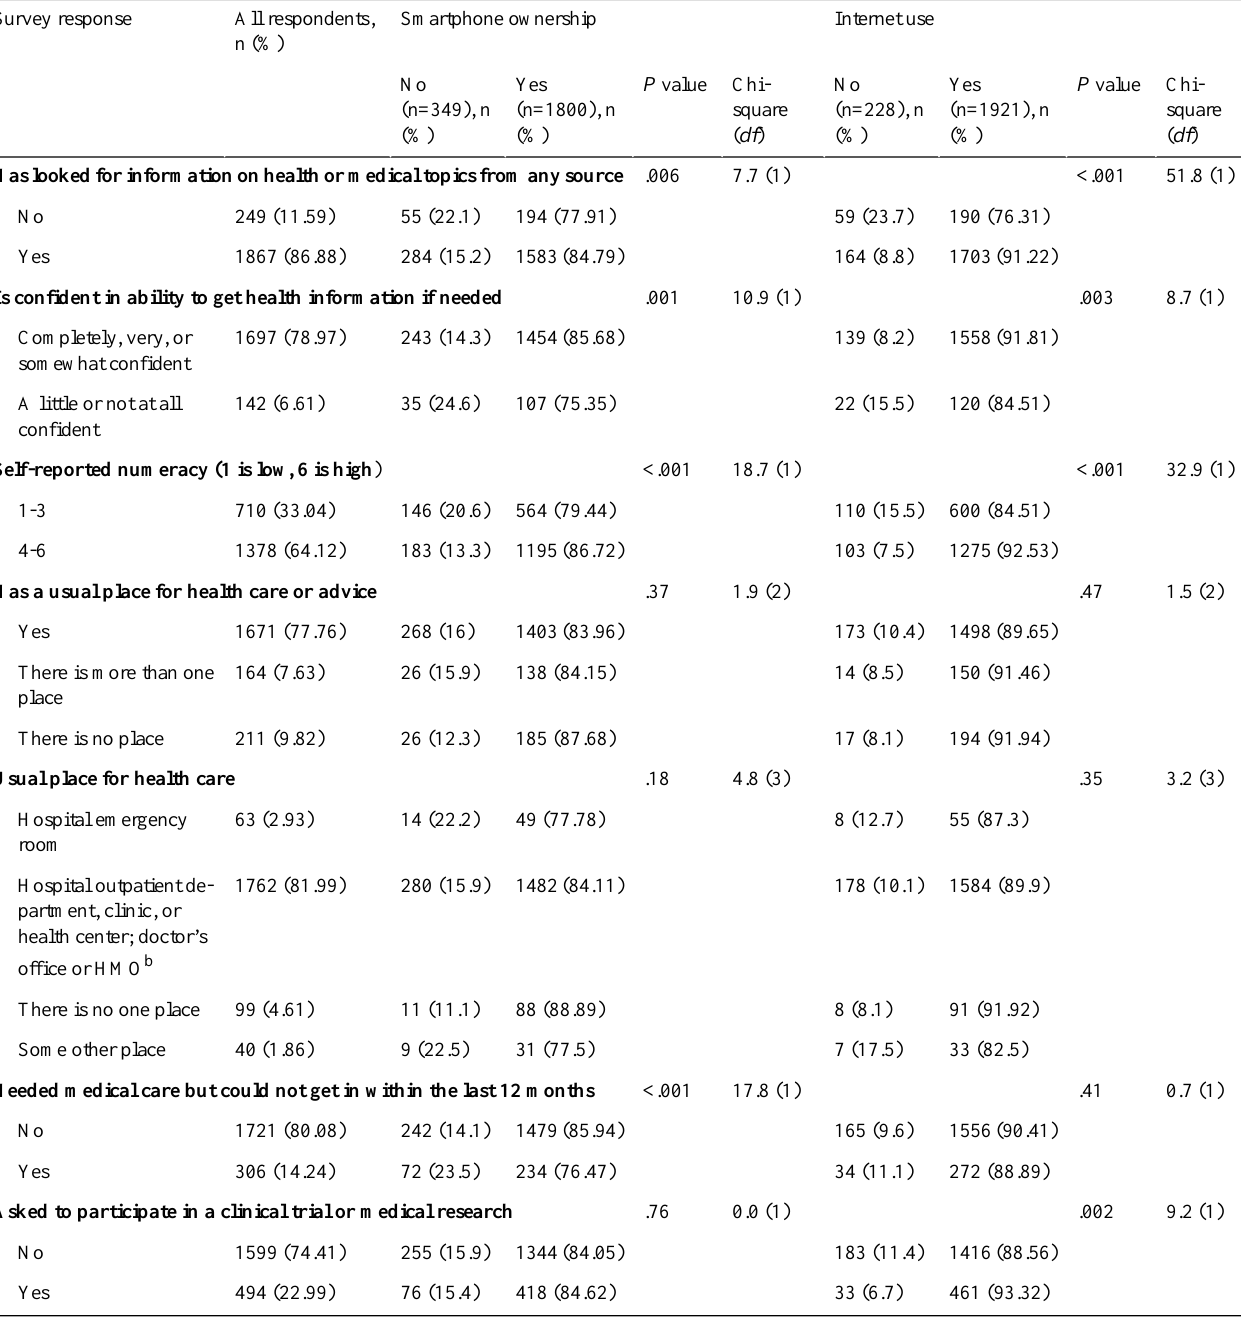
Table 2. Markers of health literacy and health access by smartphone ownership and internet use (N=2149). a